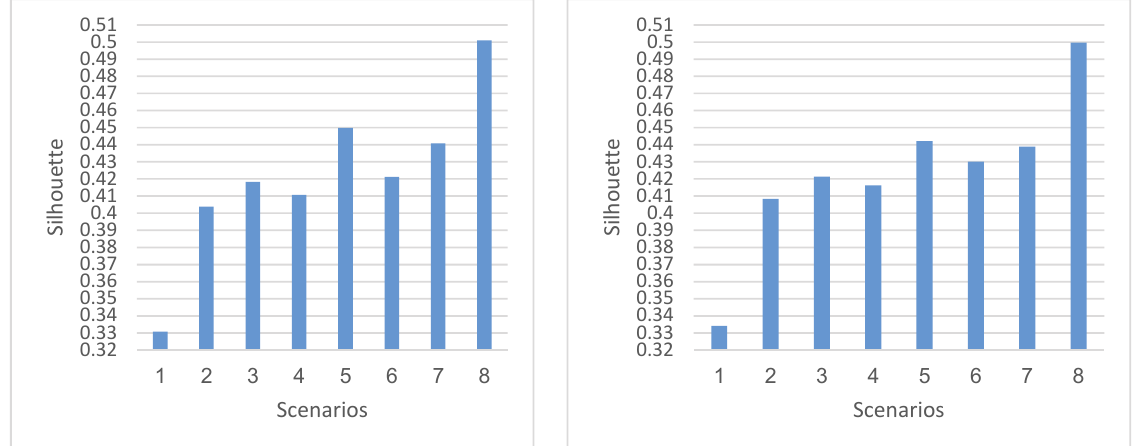
Fig. 8. Comparing silhouette values of K-means algorithm for all eight scenarios in situation 2